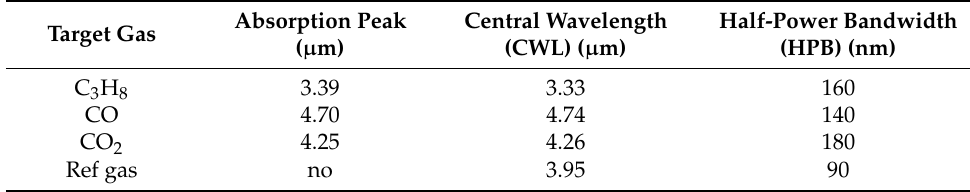
Table 1. The characteristic parameters of the four-channel filter. Target